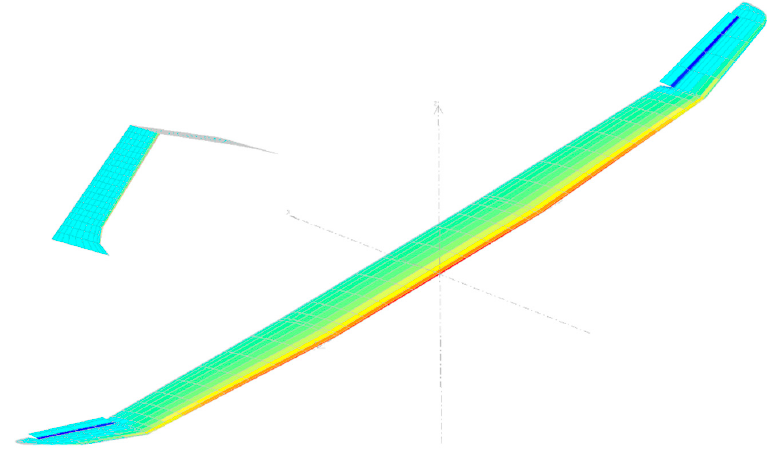
Figure 23. TWIN STRATOS UAV model in XFLR5 software.